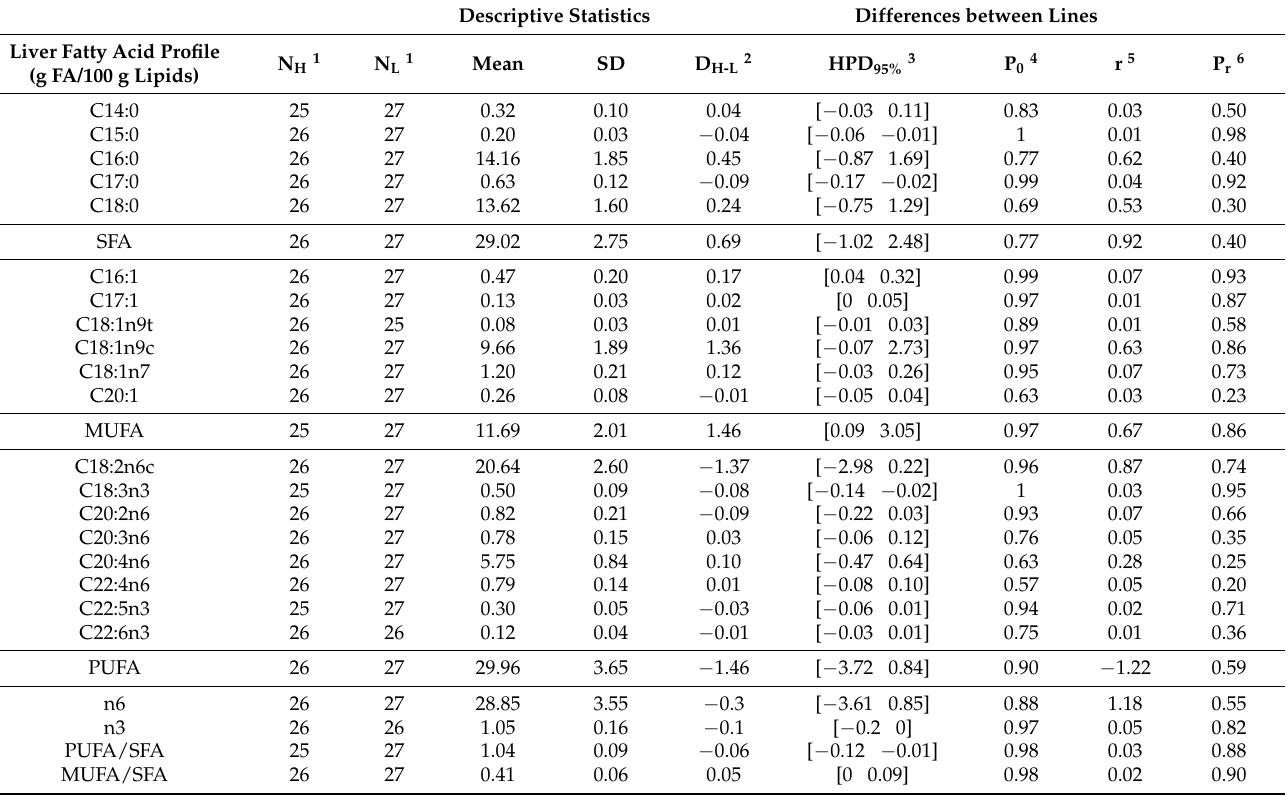
Table 4. Descriptive statistics and differences between lines of the liver fatty acid